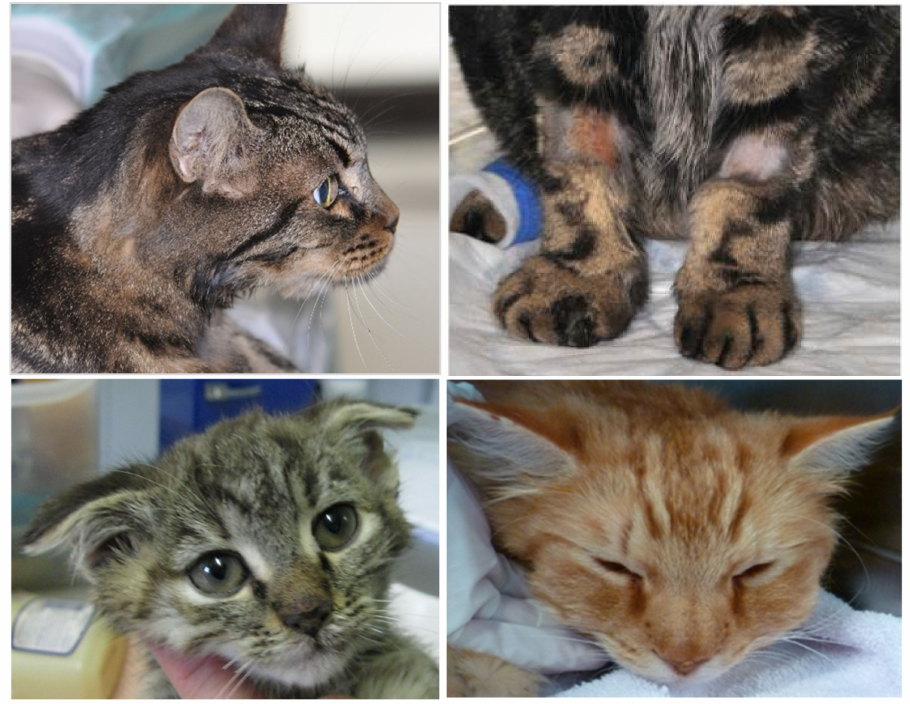
Figure 7. Oedema of the head and limbs in cats with VS-FCV infection. ©University Animal Hospital Zurich, Regina